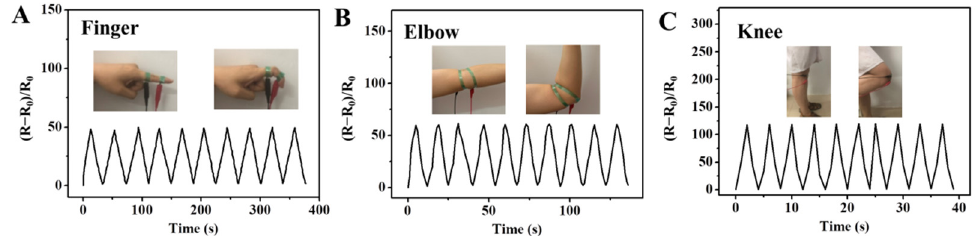
Figure 9. Monitoring of human body movements: ( A ) finger bending, ( B ) elbow bending, and ( C ) knee bending.